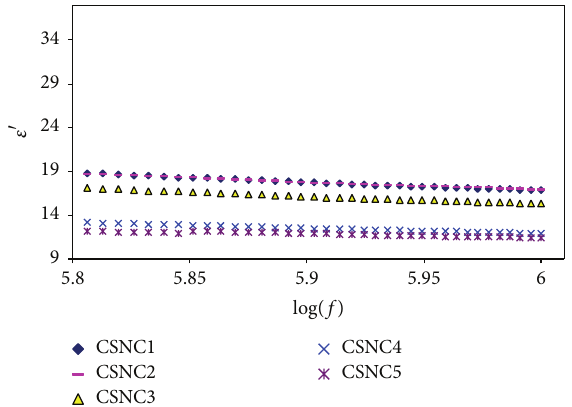
Figure 11: Composition dependence of bulk dielectric constant for CS: LiTf (90: 10)- 𝑥 Al 2 O 3 ( 2 ≤ 𝑥 ≤ 0.1 )